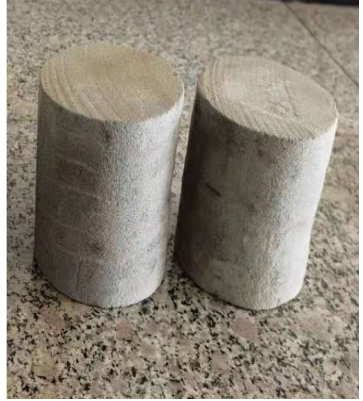
Figure 20. Part of the field filling ASPLB